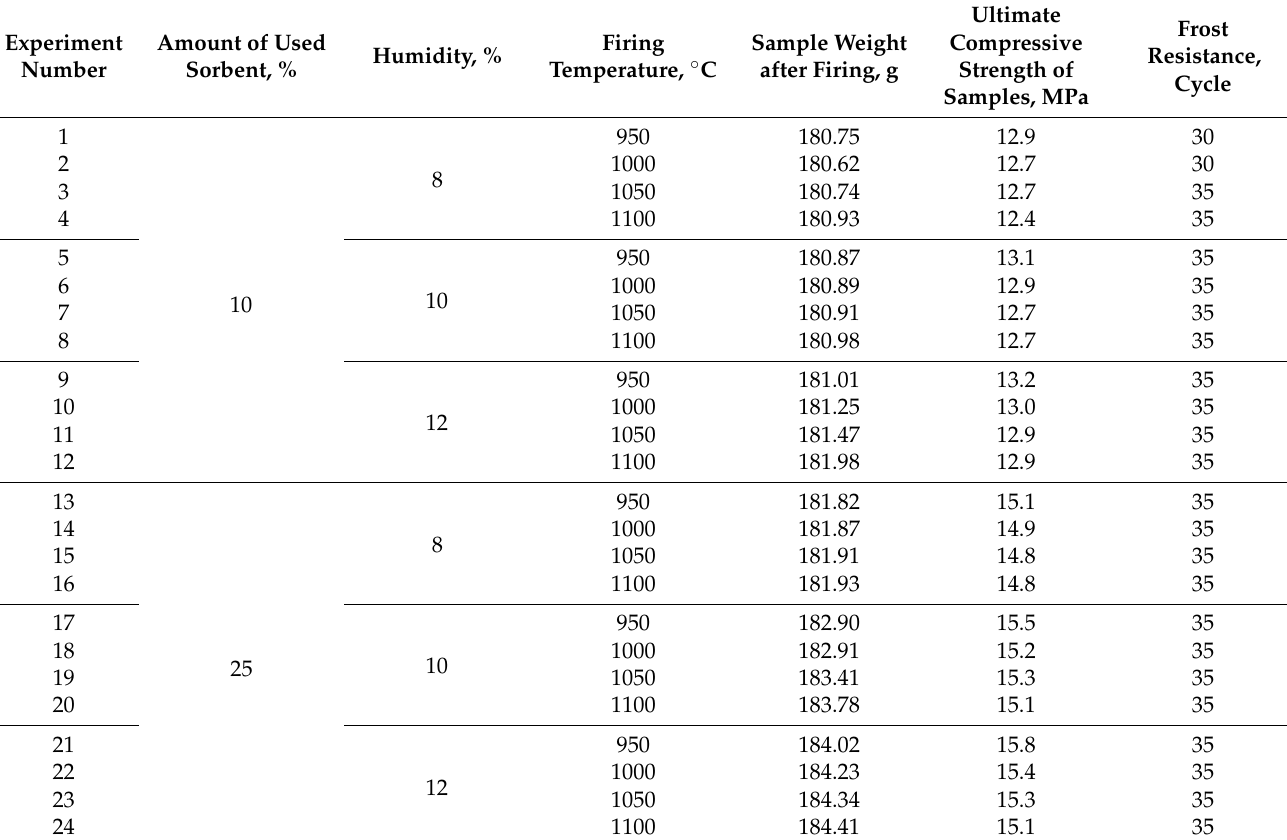
Table 7. Physical and mechanical properties of fired samples with the addition of spent